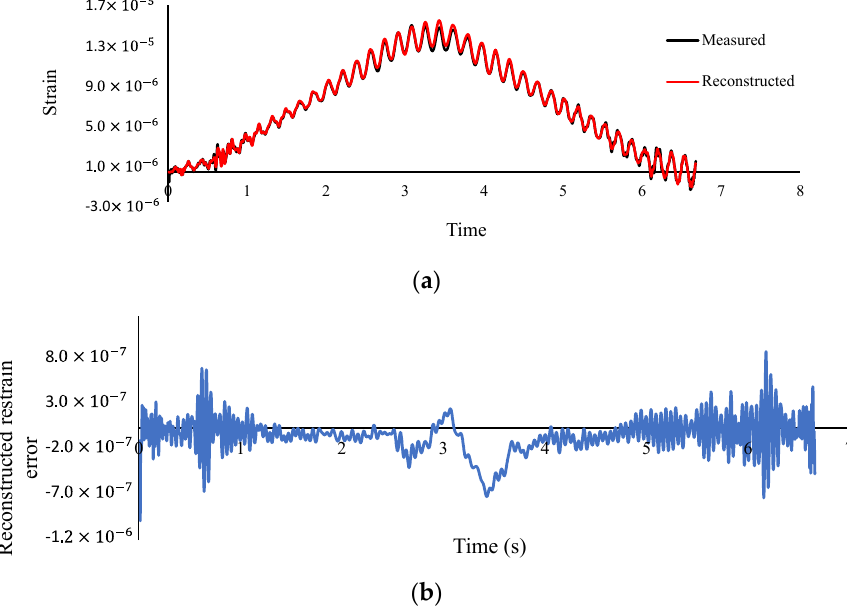
Figure 18. ( a ) Measured and reconstructed strain at mid-span ( b ) Error of reconstructed strain (Damage case 2—speed 0.47 m/s—sampling frequency 800 Hz).